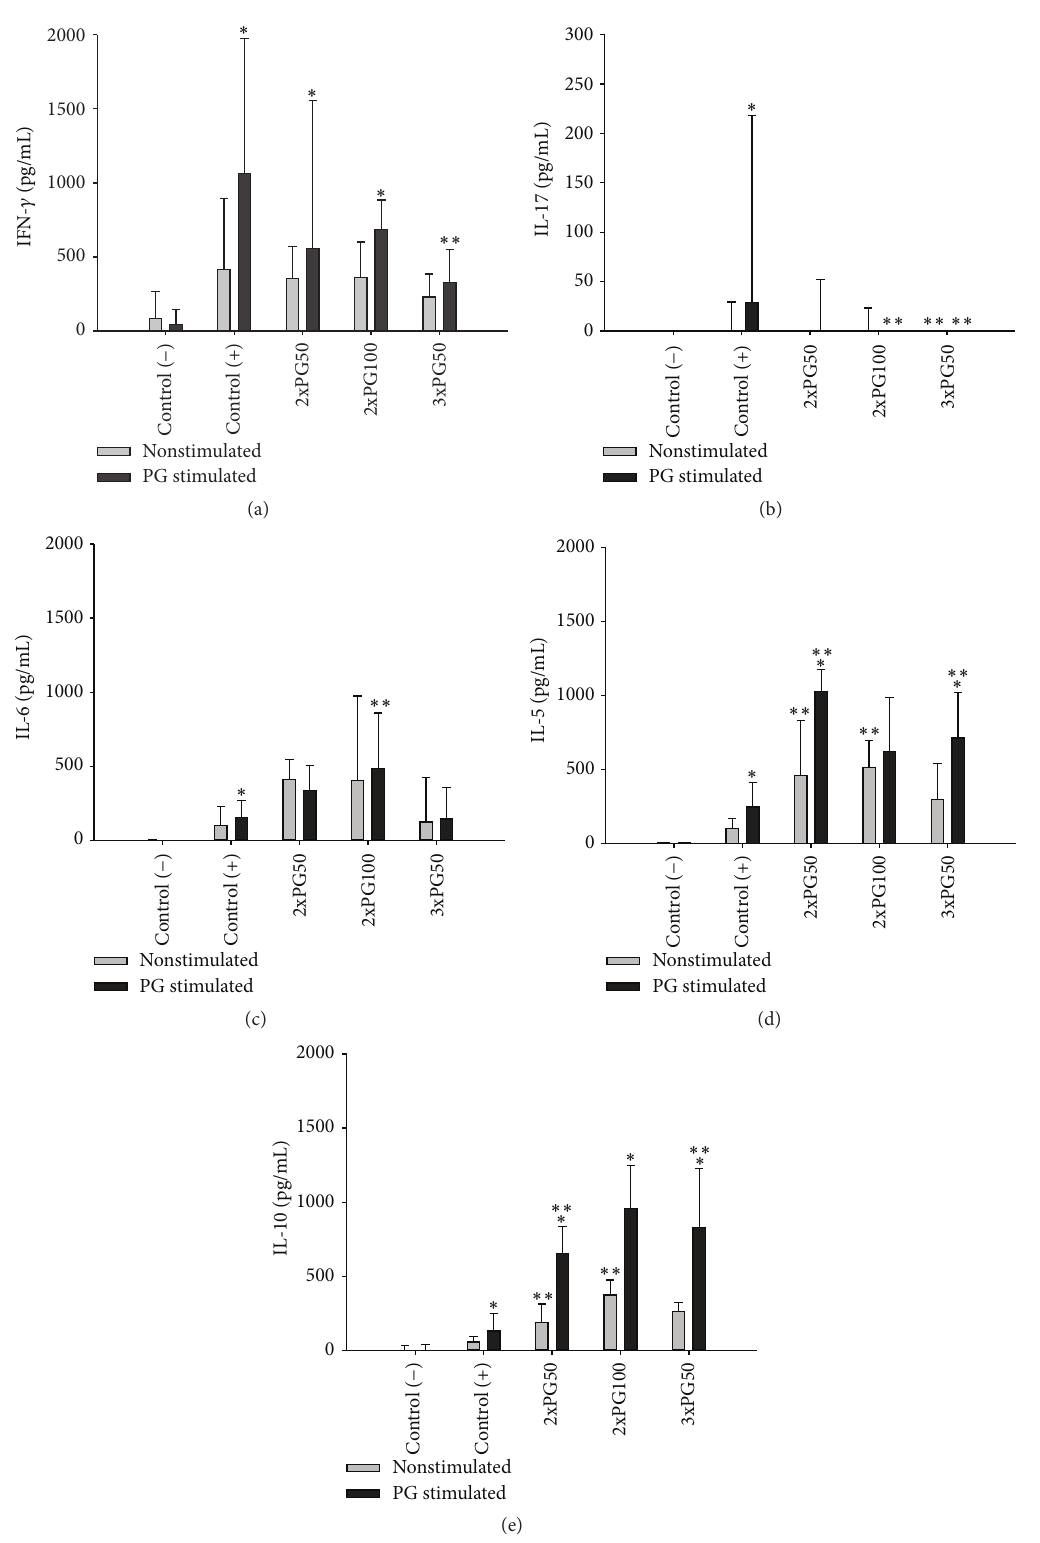
Figure 2: Effect of previous PG inoculation on cytokine production by spleen cells from arthritic mice. (a) IFN- 𝛾 , (b) IL-17, (c) IL-6, (d) IL-5, and (e) IL-10 production by spleen cells assessed by enzyme linked immunosorbent assay. Control ( − ): healthy group not previously injected with PG; control (+): arthritic group not previously injected with PG; 2xPG50, 2xPG100, and 3xPG50: arthritic groups previously injected with two (50 𝜇 g), two (100 𝜇 g), or three (50 𝜇 g) PG doses, respectively. Six to ten animals per group from one representative experiment of two performed. ∗ 𝑝 < 0.05 compared with the unstimulated counterpart and ∗∗ 𝑝 < 0.05 compared with the control (+)